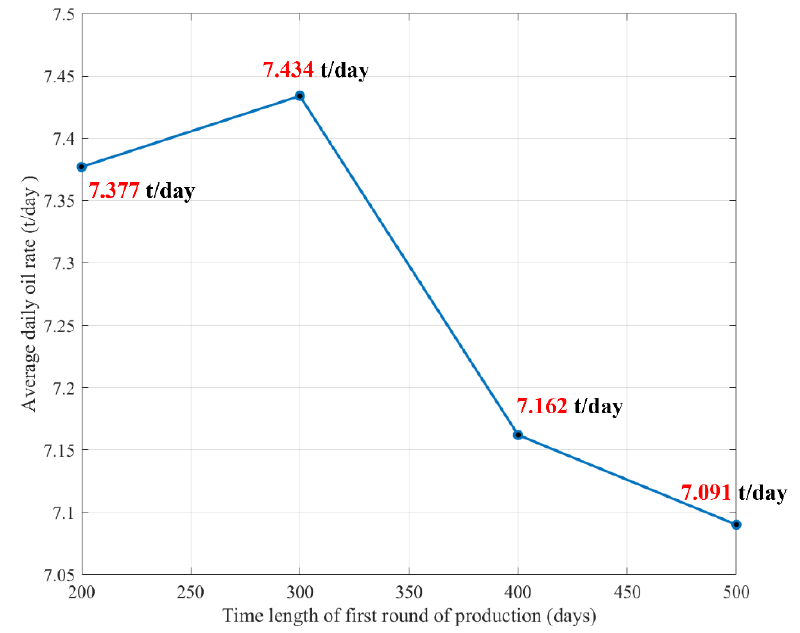
Figure 20. Average oil production rate between simulation cases with different timings of the second round of shut ‐ ins.